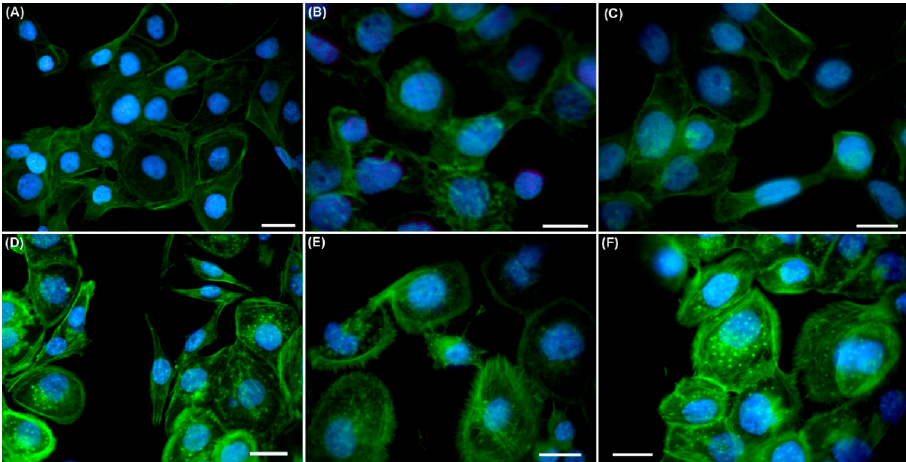
Figure 6. Effects of 60 min UVA exposure on actin cytoskeleton reorganization in keratinocytes. ( A – C )—HaCaT; ( D – F )—DOK. ( A , D )—mock-irradiated cells; ( B , E )—cells right after irradiation; ( C , F )— cells 2 h post-irradiation. Actin filaments are marked in green; nuclei are in blue. Scale bars represent 10 µm.